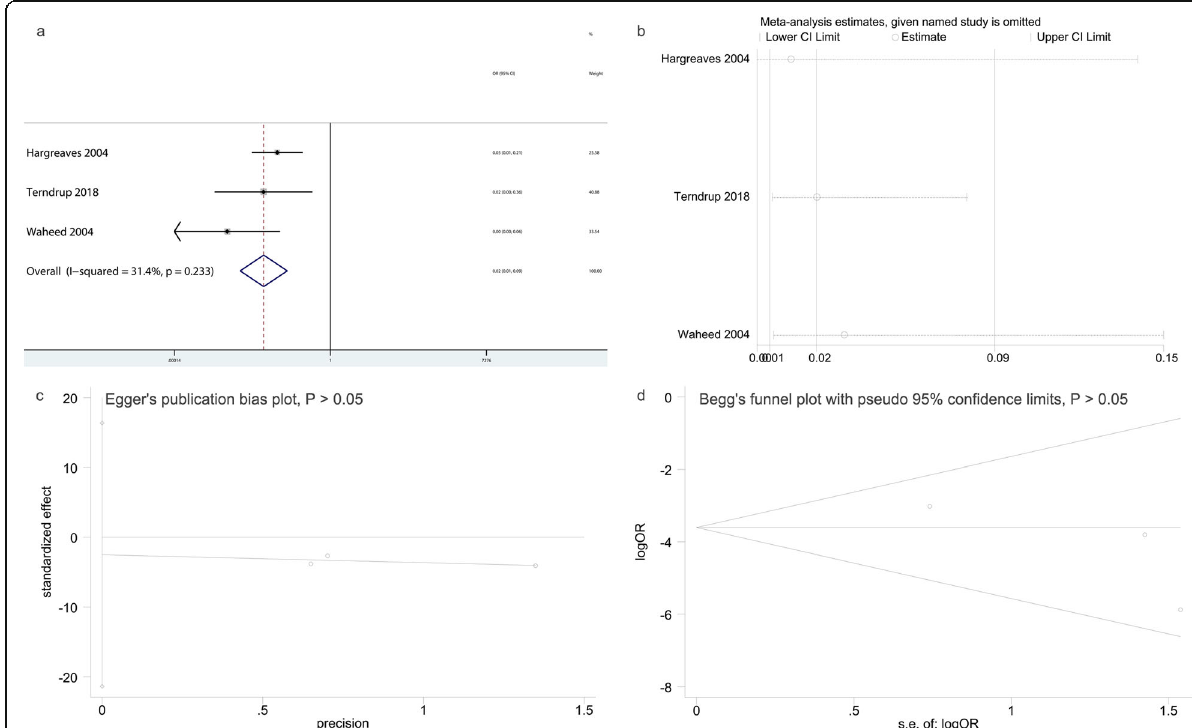
Fig. 4 The results of data synthesis for Kirschner wire removal in operating room. a : Forest plot showing the rate of Kirschner wire removal in operating room comparing buried versus exposed kirschner wire osteosynthesis for phalangeal, metacarpal and distal radial fractures; b : Sensitivity analyses for determining the reliability of results; c : Egger ’ s publication bias plot; d : Begg ’ s funnel